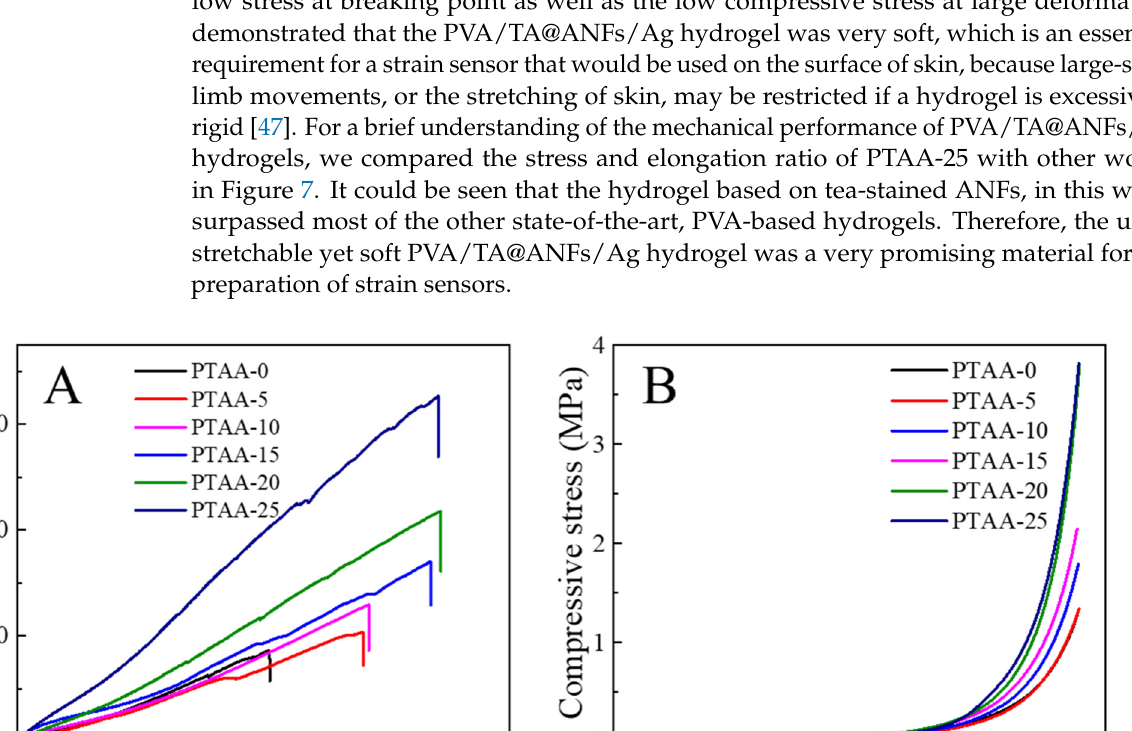
Figure 7. The tensile performance of PTAA-25 in this work and PVA-based hydrogels in others’ reports [8–9,12,14–16,21,44,48–49]. 3.4. Performance of the PVA/TA@ANFs/Ag Hydrogels as Wearable Sensors Ag NP-coated TA@ANFs were critical for the conductivity of PVA/TA@ANFs/Ag hy- drogels. We measured the initial electrical resistance ( R ) of the PTAA-0 hydrogel, which was only 0.049 ± 0.004 S/m, and could be considered insulated. Meanwhile, the R of PTAA- 25 was 1.467 ± 0.007 S/m, because Ag NPs on the surface of TA@ANFs could contact well with each other. This would suggest that a continuous and conductive network was built within the PVA/TA@ANFs/Ag hydrogels. However, this conductive network would be temporarily interrupted when the hydrogel was stretched because insulated gaps would form between two neighboring Ag NPs or TA@ANFs. Therefore, the tensile behavior caused by human bodily motions could be described by the relative variation ratio of the electrical resistance ( Δ R / R 0 ) exhibited by PVA/TA@ANFs/Ag hydrogels. As shown in Fig- ure 8A–D, the Δ R / R 0 values of the PTAA-5 hydrogel with same dimensions regularly changed with the motion of human limbs when it was pasted onto the surfaces of skin covering various joints. Rapid and stable changes in R were observed within 1 s, and 0